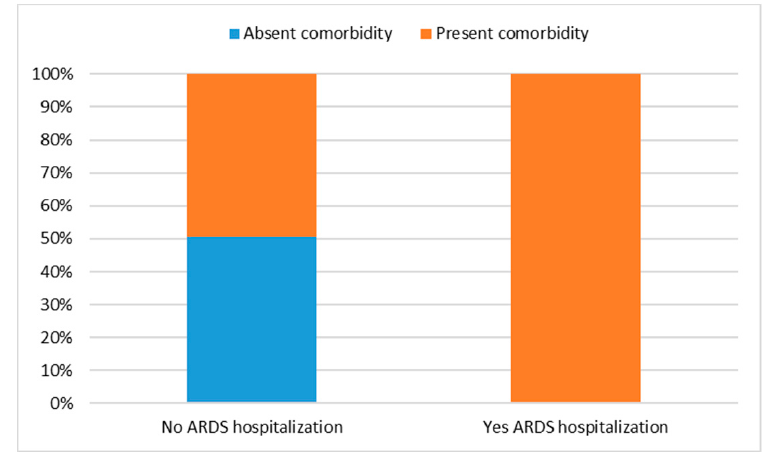
Figure 2. Association between ARDS hospitalization and comorbidity.